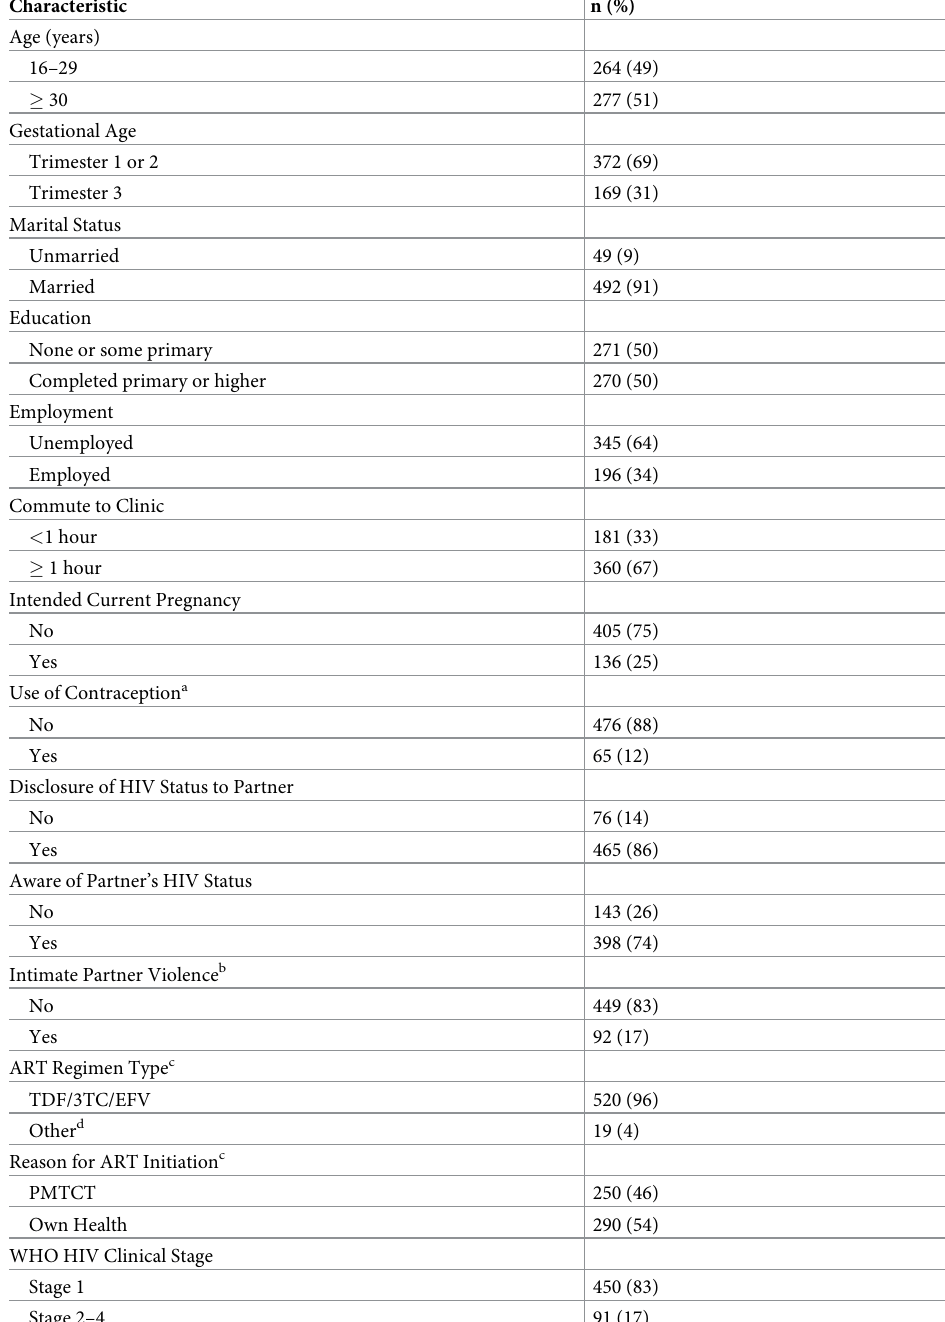
Table 1. Characteristics of study participants at enrollment (N =